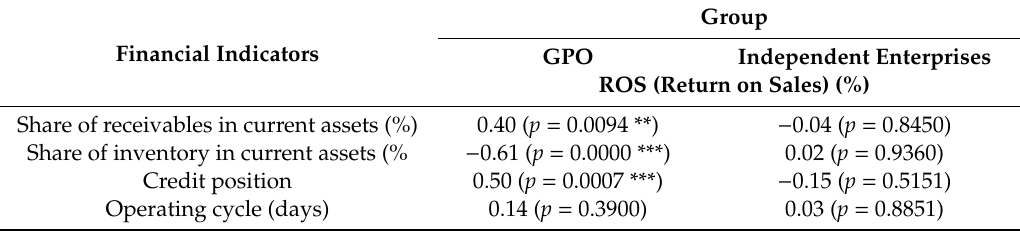
Figure 3. Scatter chart of receivables and inventory turnover cycles. Source: author’s calculations and studies. Table 5. Spearman’s rank coefficient of correlation between the profitability level of companies from both groups and the selected indicators—efficiency, share of receivables and inventory and credit position (with result of significance test).